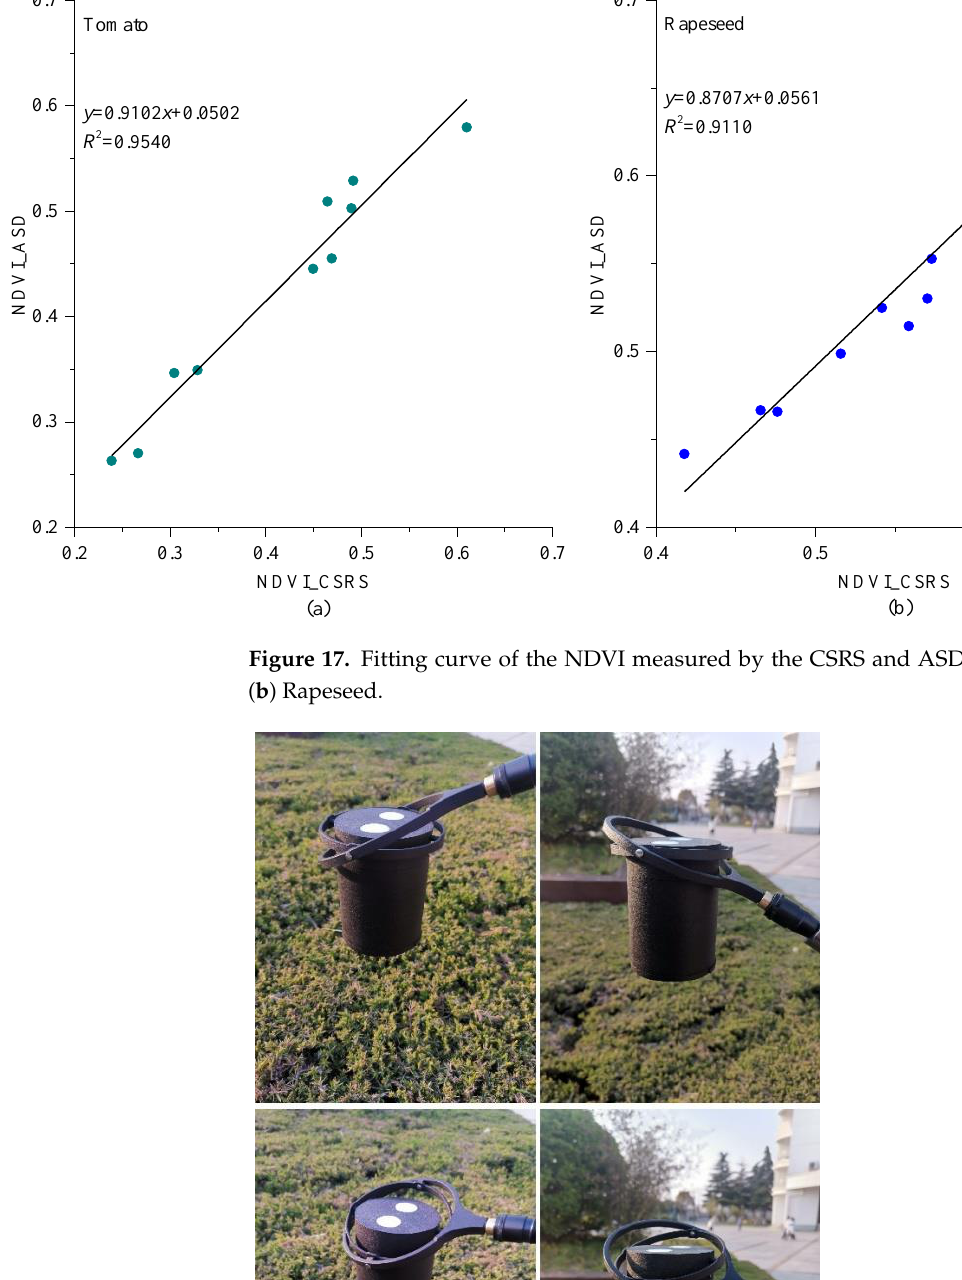
Figure 17. Fitting curve of the NDVI measured by the CSRS and ASD spectrometer. ( a ) Tomato; ( b ) Rapeseed.